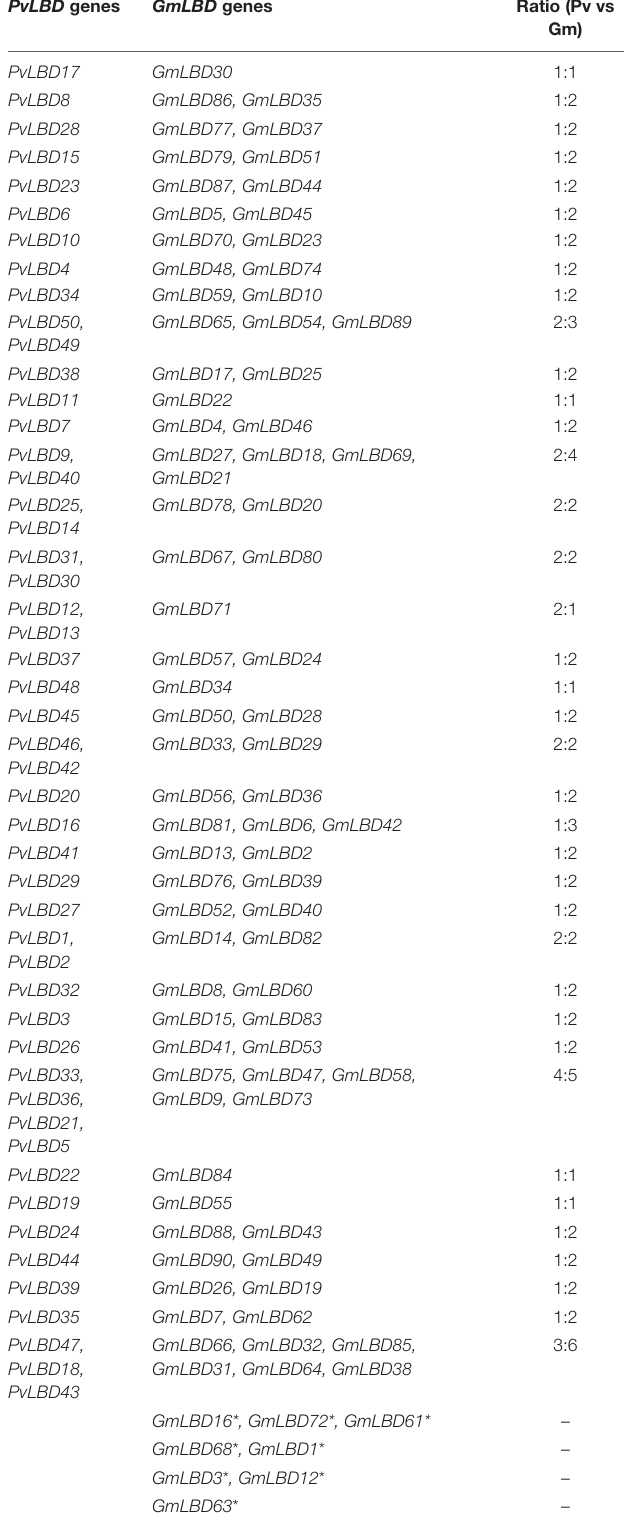
TABLE 1 | Summary of GmLBD and PvLBD synteny gene pairs derived from phylogenetic analysis. PvLBD genes GmLBD genes Ratio (Pv vs PvLBD17